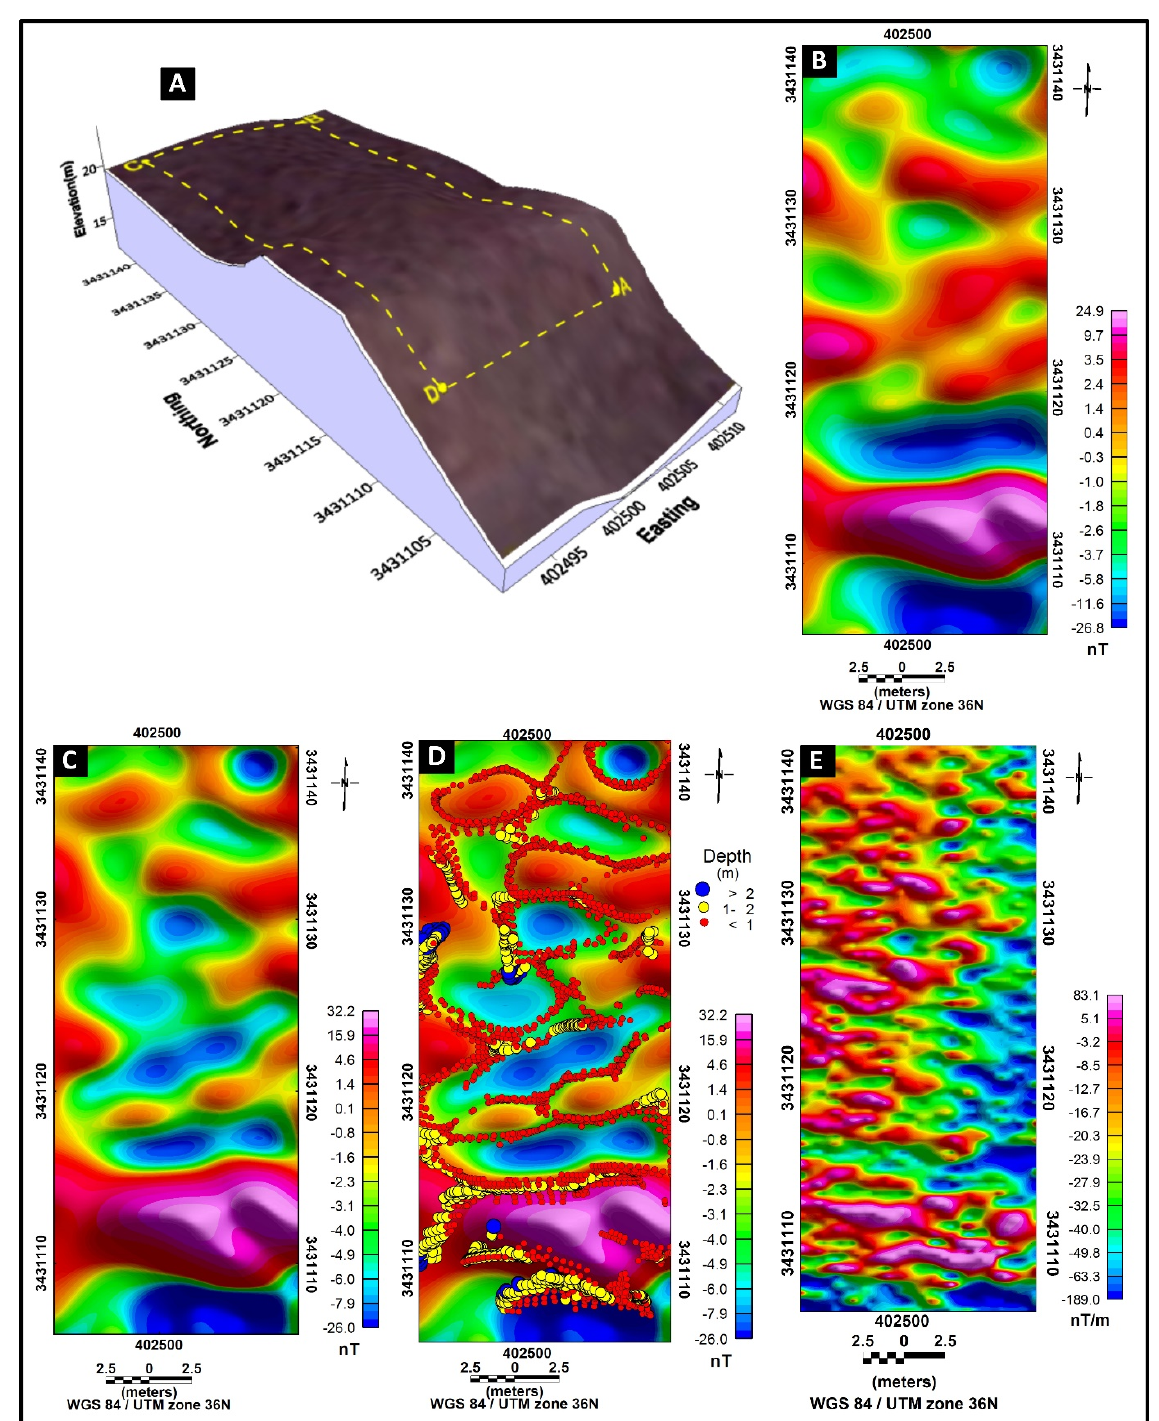
Figure 11. Magnetic results at the area around Spot C: (A) 3D geometry of the actual location of the area covered by the magnetic survey; (B) Butterworth filtered map; (C) first vertical derivative map; (D) 3D Euler deconvolution solutions superimposed onto the first vertical derivative map; and (E) vertical gradient using sensors spaced 0.6 m apart.